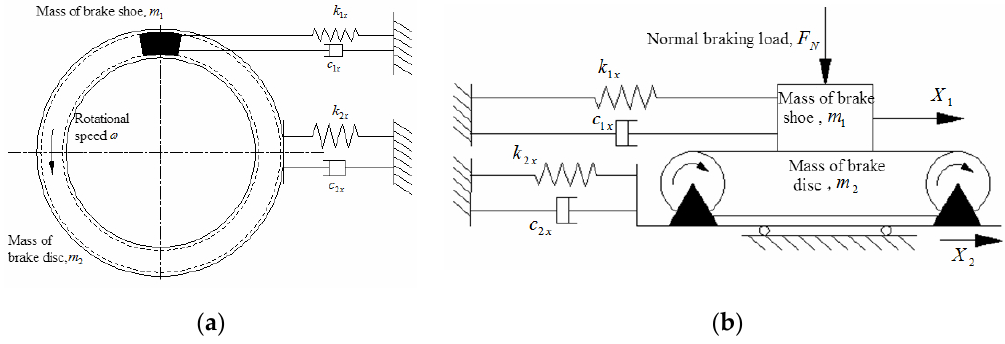
Figure 12. The dynamic model of the disc brake shoe. ( a ) Simplified dynamic model of brake shoe and brake disc. ( b ) Dynamics model of disc brake system.